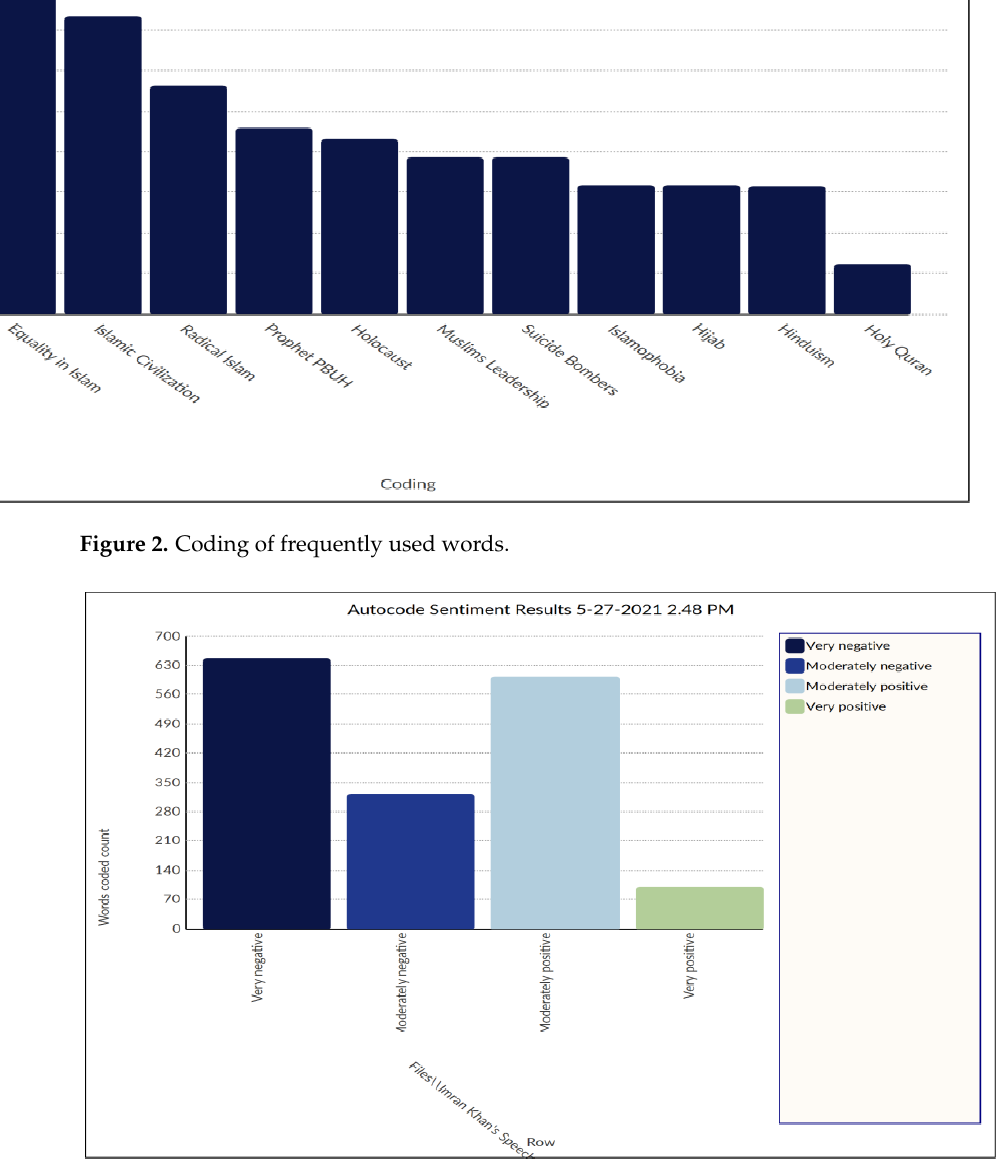
Figure 2. Coding of frequently used words.